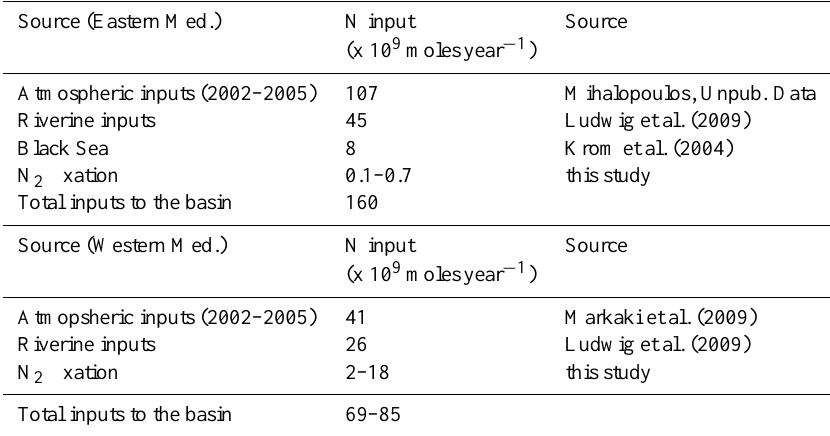
Table 4. Calculated external N inputs to the eastern and western Mediterranean basins without taking into account the exchanges at the straits and winter convection. All values are given in 10 9 molesyear − 1